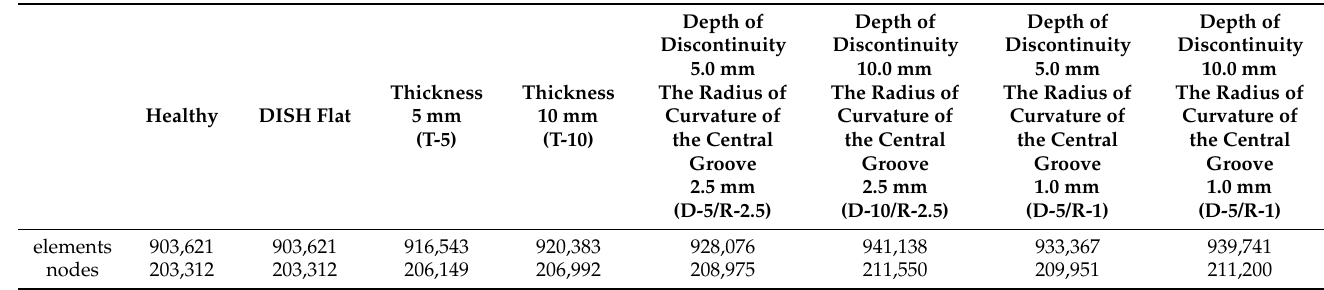
Table 2. Elements of the nodes of each model are shown.